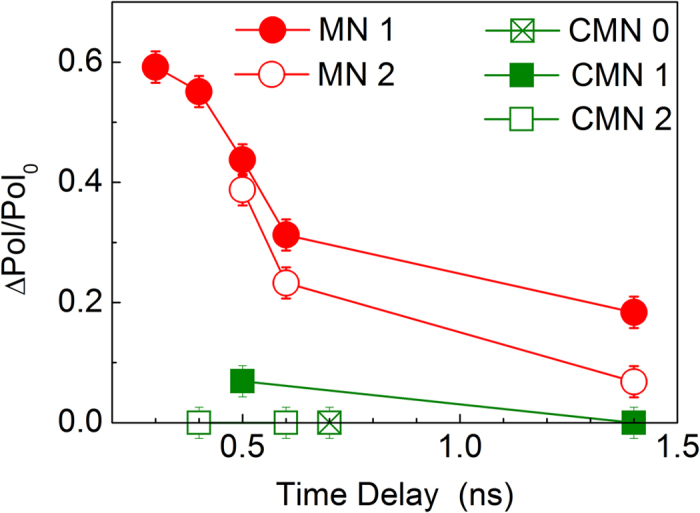
Time-delay (Δt) dependence of the ratio (ΔPol/Pol0) for all the investigated samples.